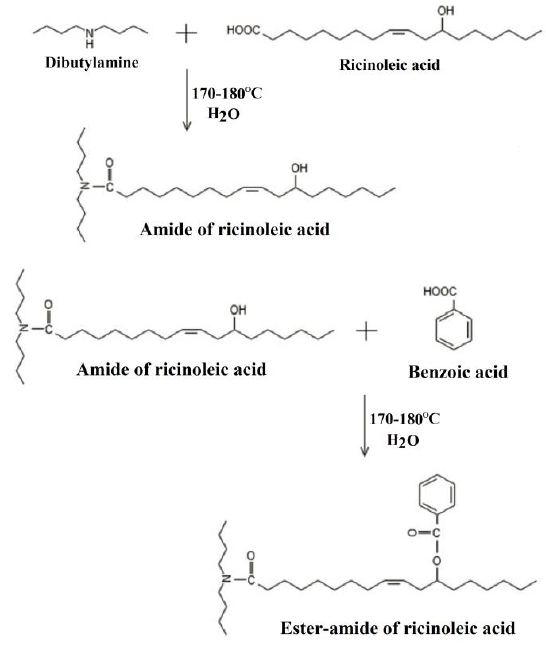
Figure 22. Synthesis of ester-amide of ricinoleic acid.